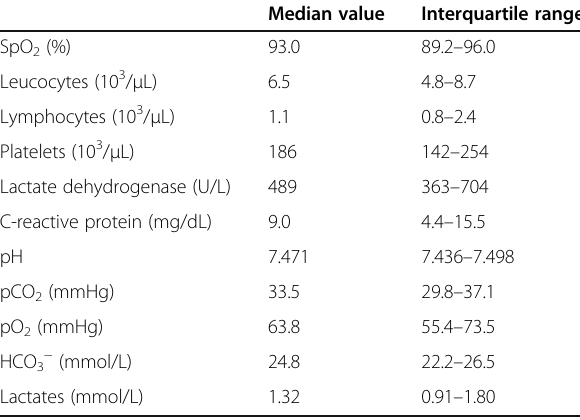
Table 1 Laboratory and clinical characteristics on admission of the 295 patients included in the